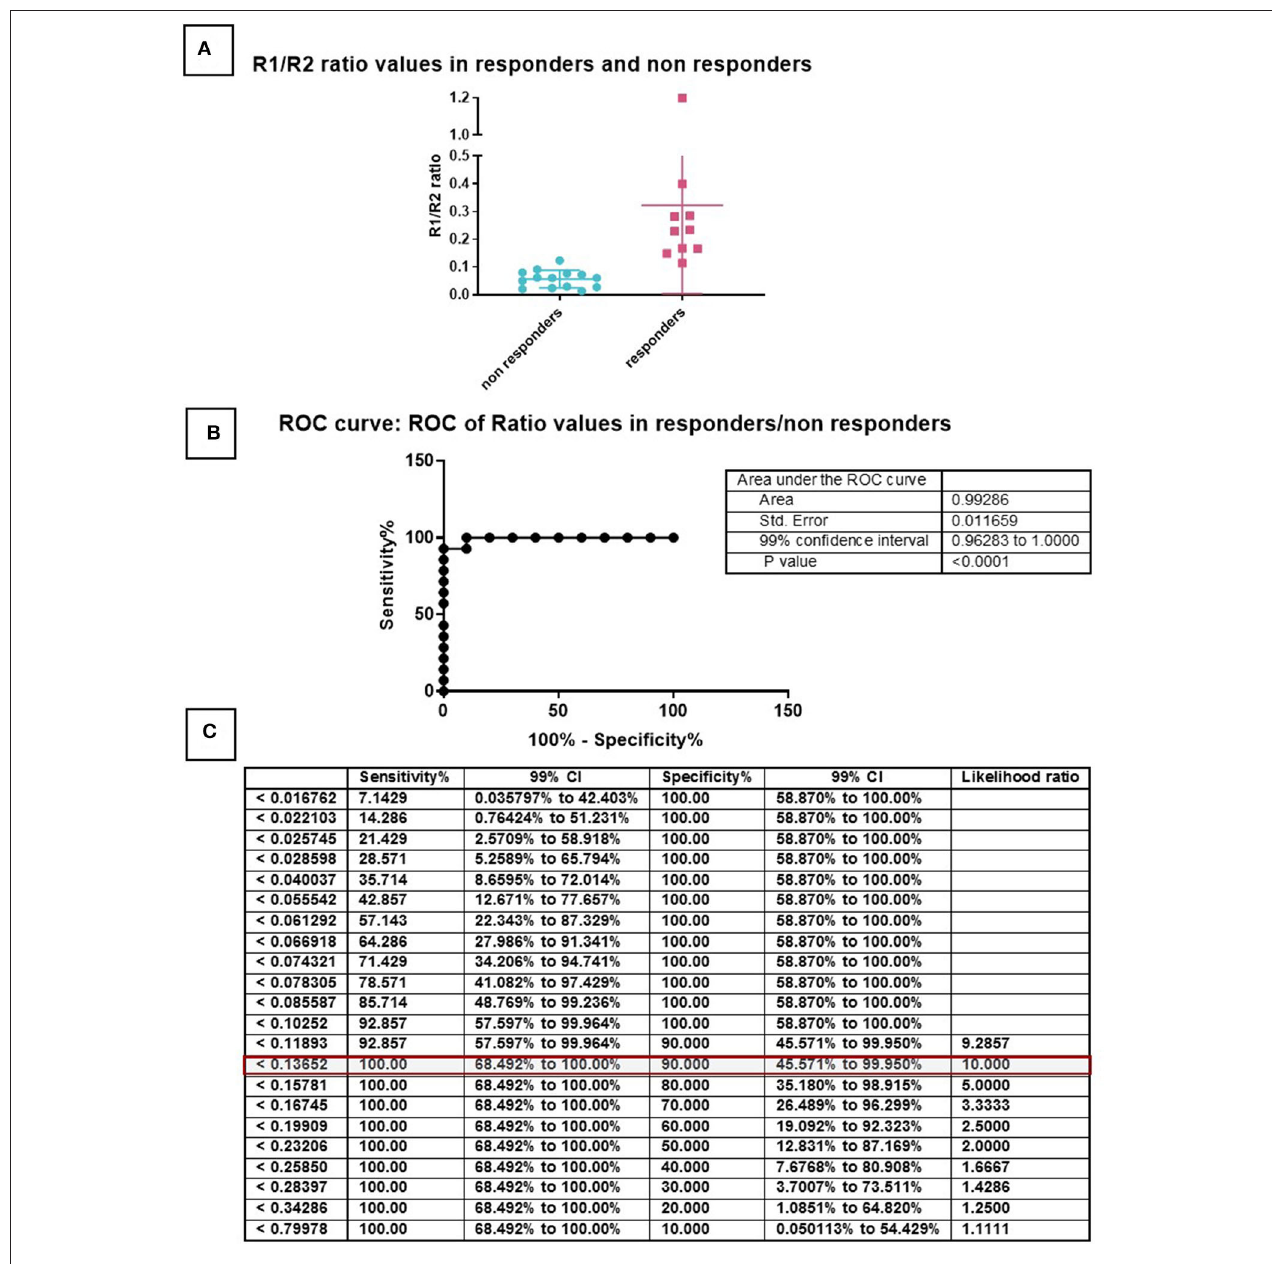
FIGURE 5 | ROC curve for the determination of a cut-off. Samples were divided in two groups based on the histological score and TGFBR1/TGFBR2 ratio (A) . Non-responders have score 1–5 (green), Responders have score 6–10 (red). This division made it possible to generate a ROC curve (B) and calculate cut-offs for specificity and sensitivity (C)